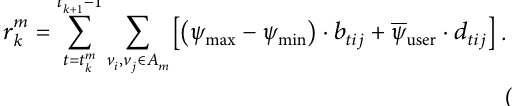
subzone of w m . For example, in Figure 4, v , v , v , v , v , v 􏼈 􏼉 is the set of arcs adjacent to v 4 0 4 1 4 7